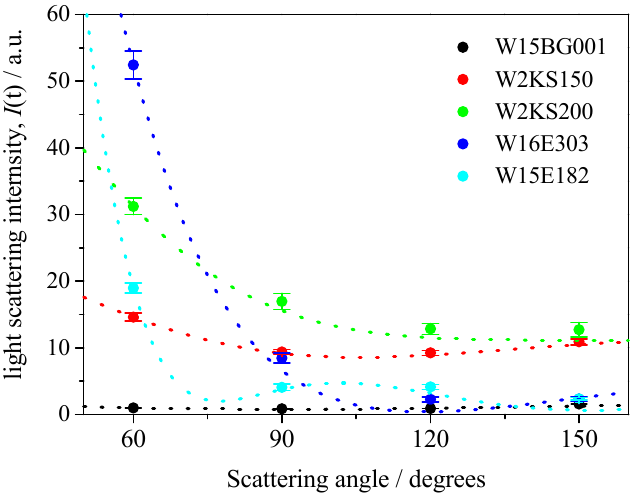
Figure 3. Plots of angler dependency of scattering intensity of polystyrene latex particles at the same mass (weight) concentration. The dotted lines are theoretical light scattering intensities for corresponding sized particles. The observed light scattering intensities were normalized by the intensity of W15BG001 at a scattering detection angle of 60°.